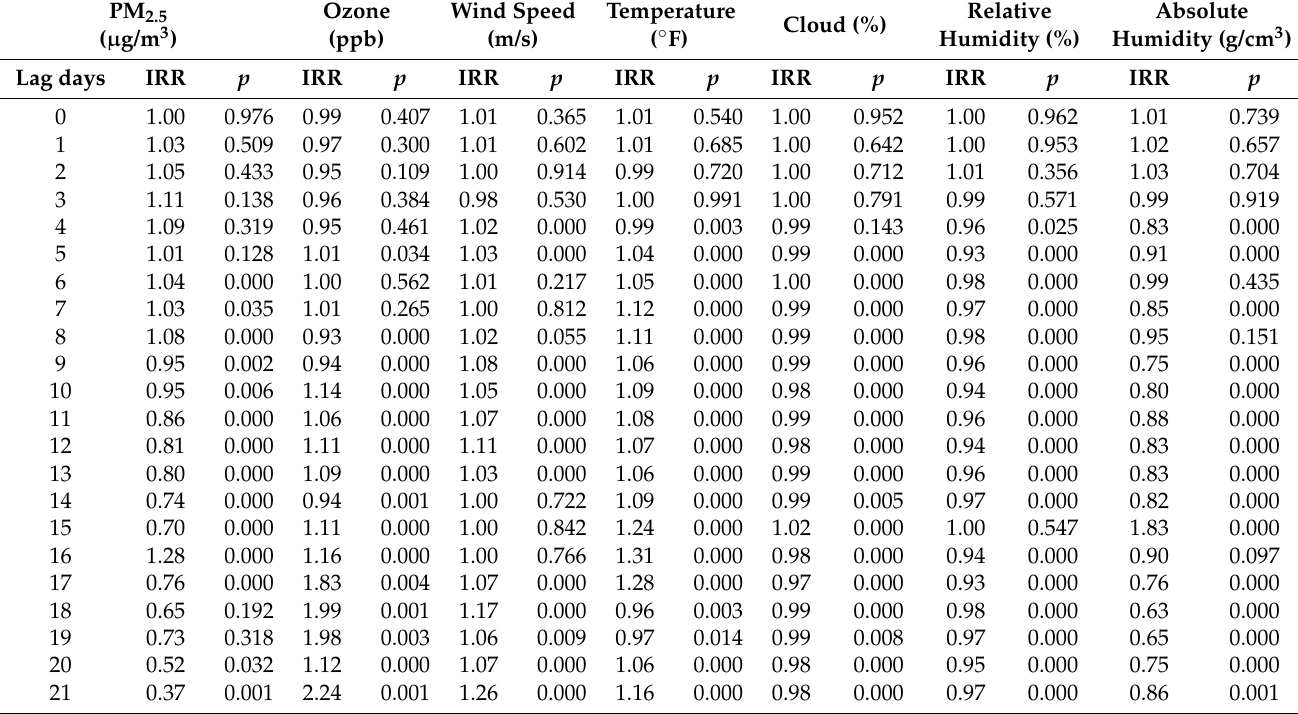
Table 1. Actual incidence rate ratios (IRRs) and p numerical values for lags of days from 0 to 21 days. PM 2.5 ( µ g/m 3